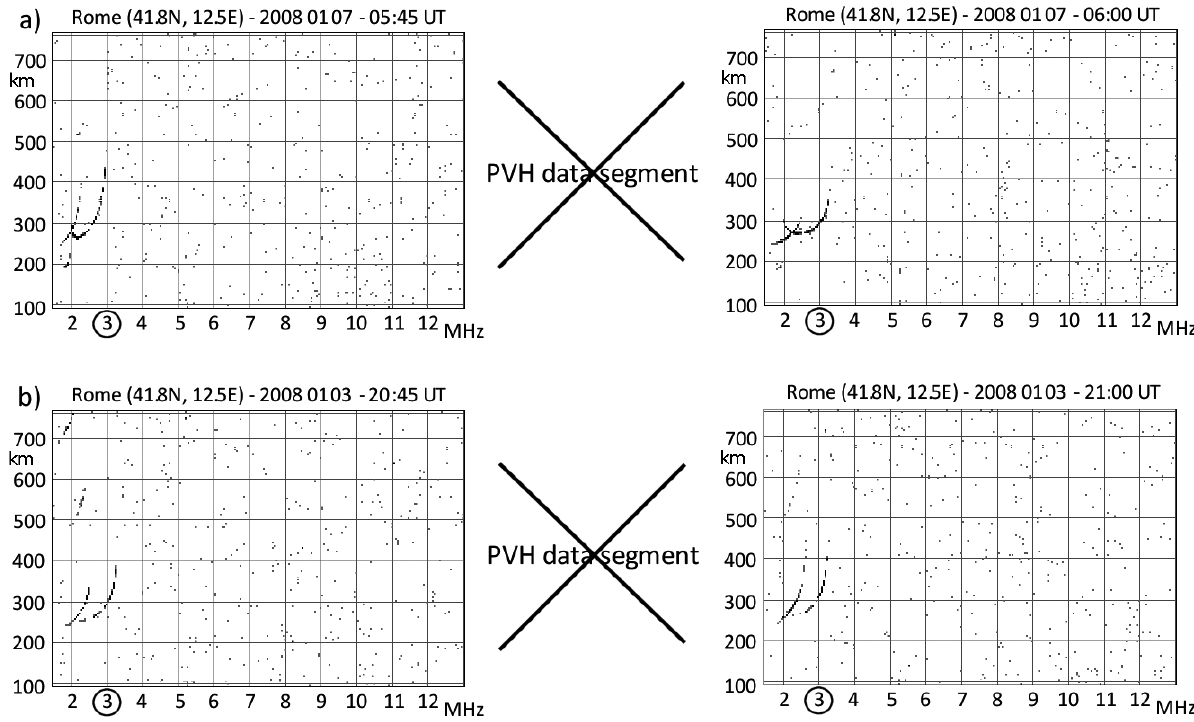
Figure 2. Cases for which the inspection of the two consecutive ionograms helped the data analyzer in discarding the corresponding PVH data segment because: (a) the maximum reflected frequency of the first ionogram is below the value of 3.0 MHz (highlighted by an open circle and corresponding to the PVH operating frequency); (b) the PVH operating frequency propagates up to the highest ionospheric lay- ers and this fact prevents from neglecting the polarization losses (see Section